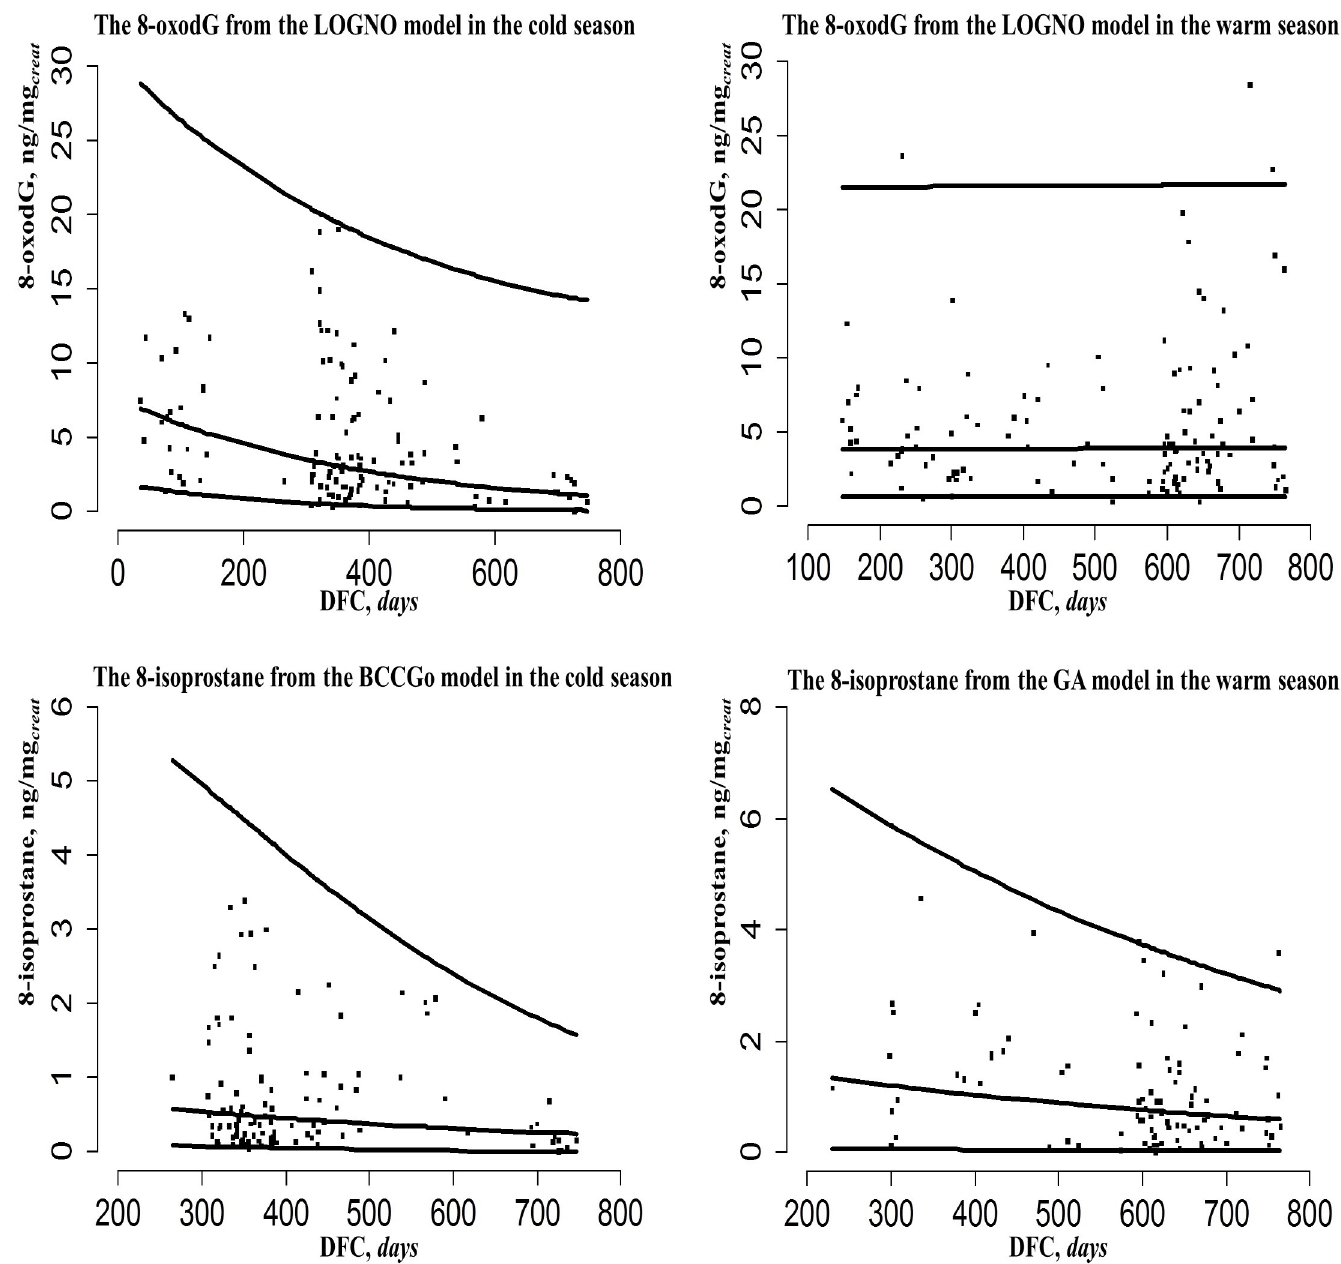
Fig 1. The observed 8-oxodG and 8-isoprostane values with three fitted model centile curves (2.5%, 50%, 97.5%) against the DFC in two seasons. Three values of the 8-oxodG ng/mg creat and 8-isoprsotane ng/mg creat at the lowest, median and highest values of the distance from collection (DFC) are shown on the median (50%) centile curves of each biomarker in each season. Distribution families: LOGNO—log-normal; BCCGo–Box-Cox Cole and Green; GA–Gamma.